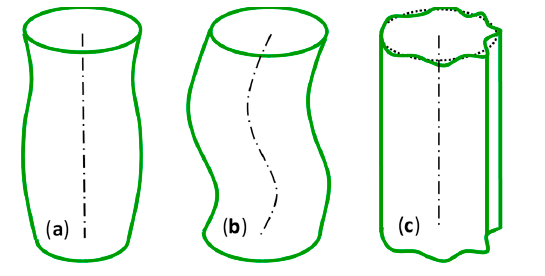
Figure 1. Components of the cylindricity deviations.